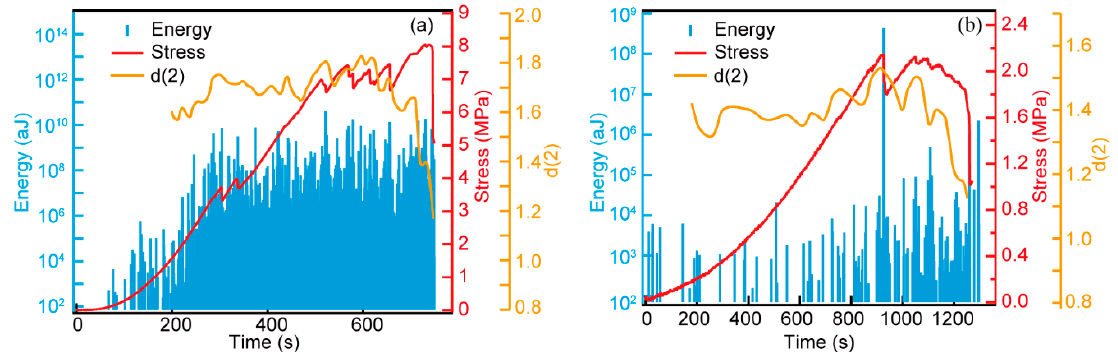
Figure9. CorrelationdimensionresultsoftheAEhypocentersdistributions, AEenergyandcompression Figure 9. Correlation dimension results of the AE hypocenters distributions, AE energy and stress for ( a ) non-tectonic and ( b ) tectonic compression stress for ( a ) non-tectonic and ( b ) tectonic coal.